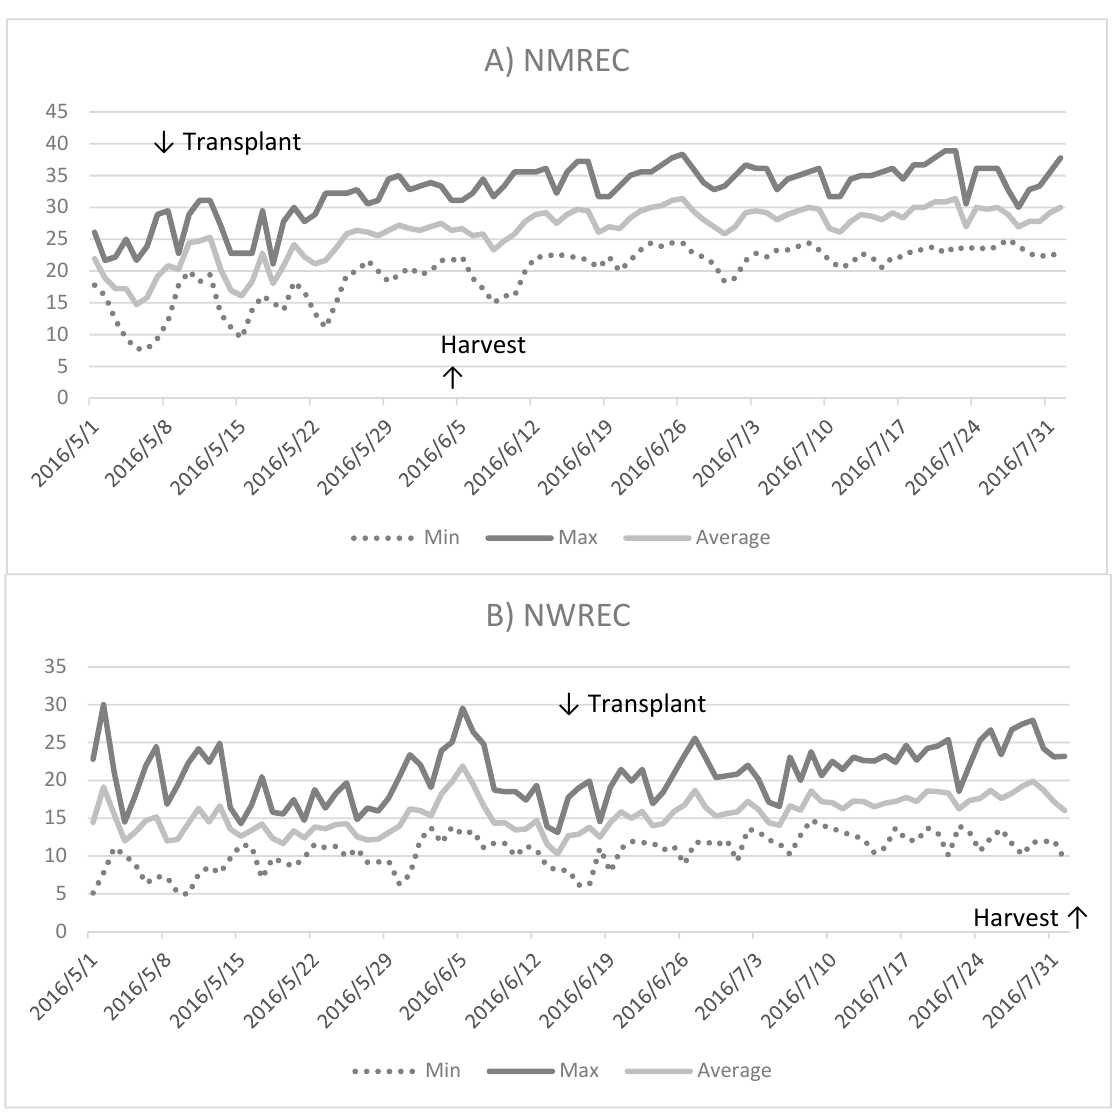
Figure 1. Minimum, maximum, and average temperatures from May to August 2016 at ( A ) the North Mississippi Research and Extension Center (NMREC) in the Mississippi State University, Verona, MS, USA and ( B ) the Northwest Washington Research and Extension Center (NWREC) in the Washington State University, Mount Vernon, WA, USA.